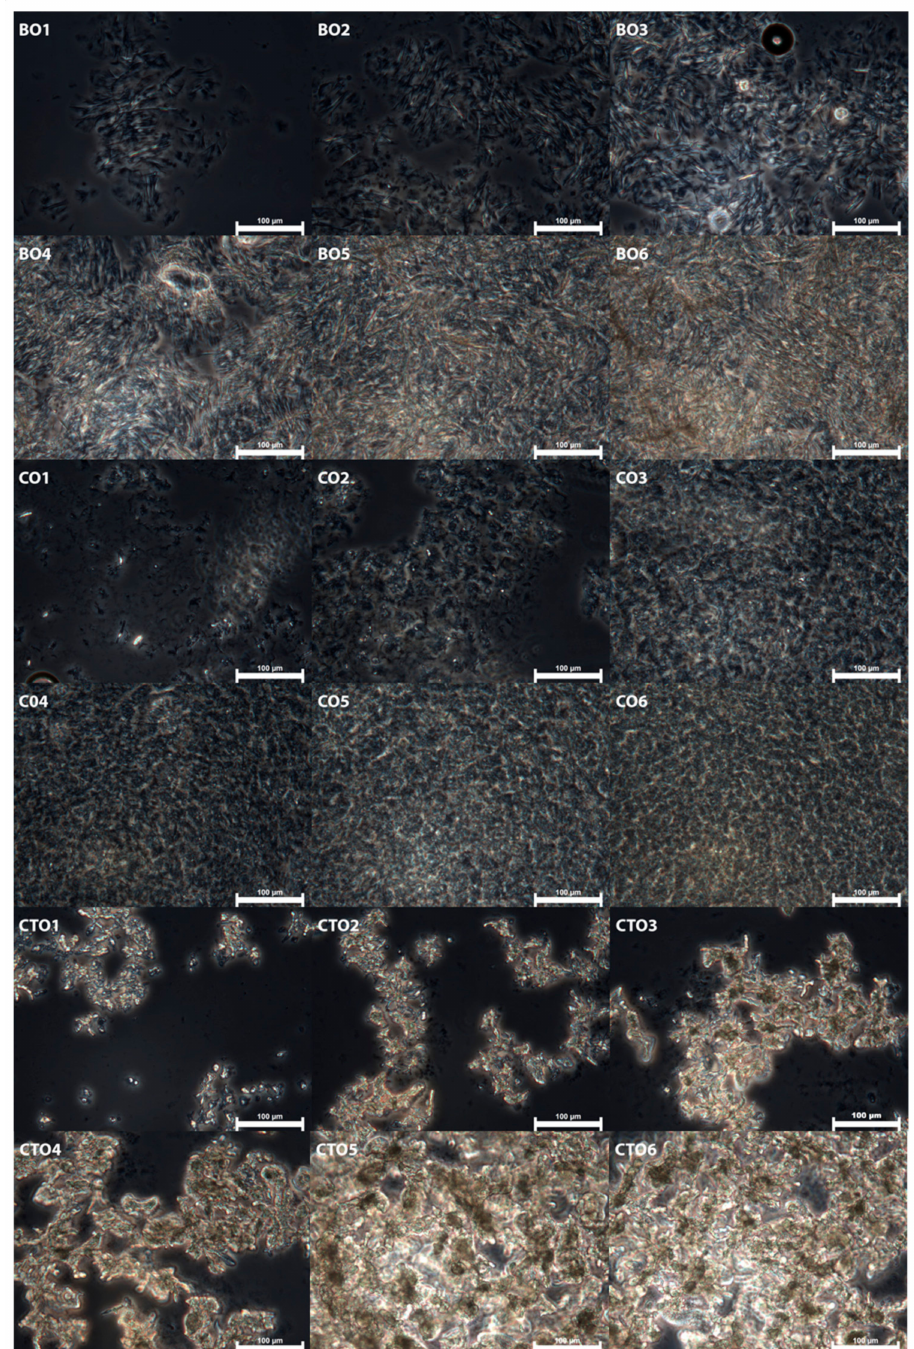
Figure 2. Phase contrast micrographs for all organogels after